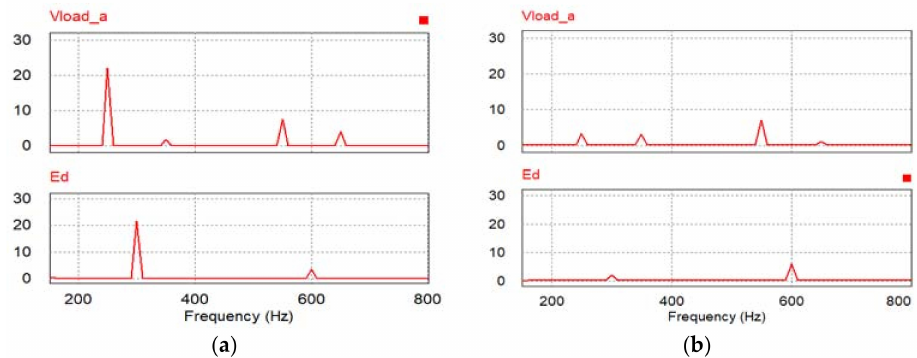
Figure 23. FFT analysis of PI + MR control inverter under a nonlinear load. ( a ) Conventional controller; ( b ) Resonant controller.